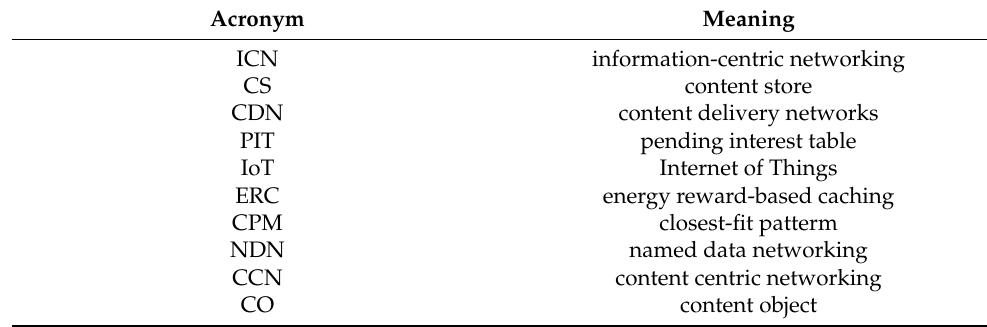
Table 1. List of